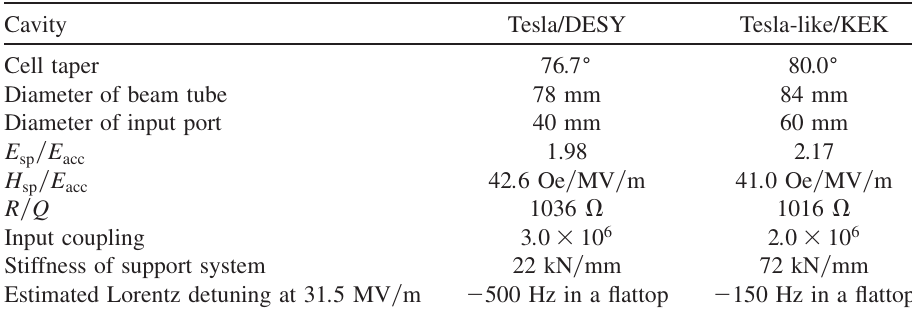
TABLE I. Comparison of main cavity parameters.